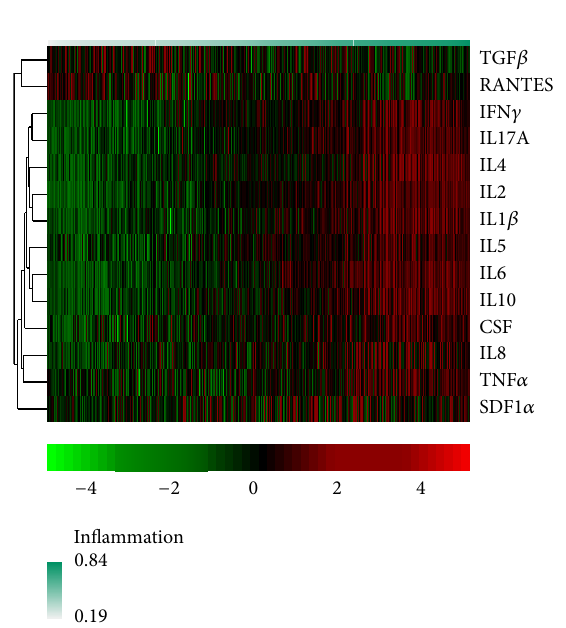
Figure 2: Heat map representing the cytokine and chemokine concentration values for each woman in all three groups through- out pregnancy. Whereas the three trimesters of pregnancy are represented on the first upper horizontal line, the three study groups in all three trimesters of pregnancy are represented on the second horizontal line. It can be observed that most cytokines and chemokines follow a similar pattern during pregnancy; their concentration rises in the second trimester and remains high in the third trimester of pregnancy. RANTES, regulated upon activation normal T-cell expressed and secreted; TGF 𝛽 , transforming growth factor-beta; IFN 𝛾 , interferon-gamma; IL, interleukin 17, IL4, IL1 𝛽 , IL2, IL5, IL10, and IL6; GM-CSF, decidual granulocyte-macrophage colony-stimulating factor; IL8; TNF 𝛼 , tumor necrosis factor-alpha; and SDF1 𝛼 , stromal cell-derived factor 1 alpha.